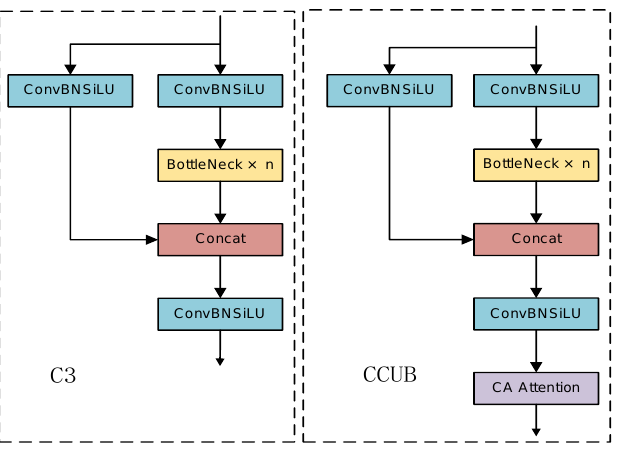
Figure 10. The C3 module used by YOLOv5 vs. the CCUB module used by YOLOv5_CBS.